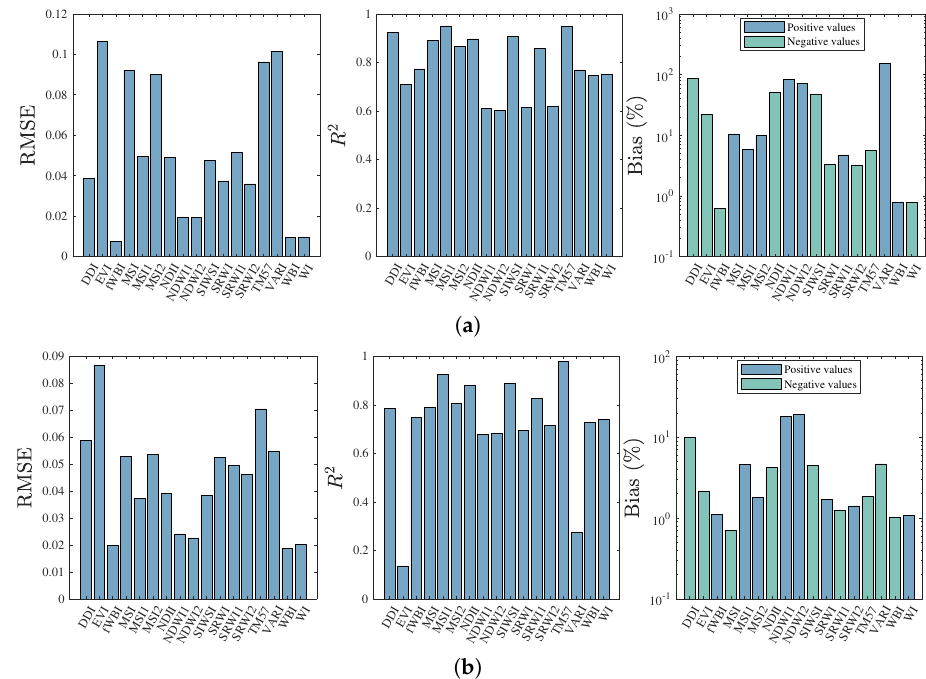
Figure 3. Evaluation of model performance for retrieval of vegetation indices. Where: ( a ) Pinus radiata and ( b ) Eucalyptus globulus .